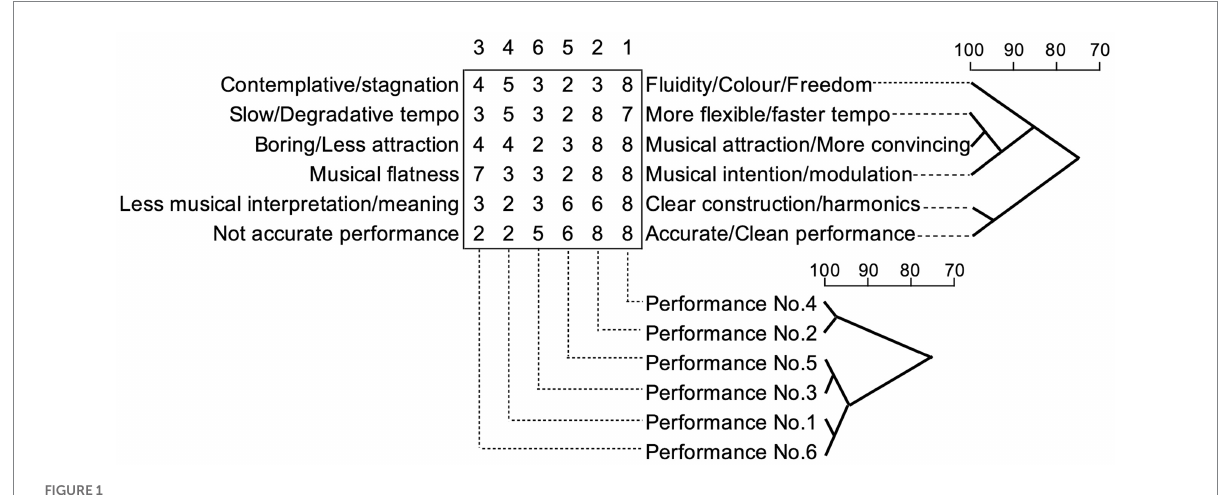
FIGURE 1 Sample grid from performer